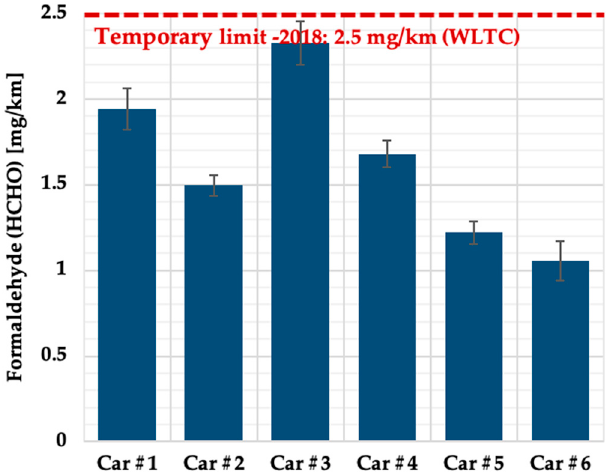
Figure 7. Formaldehyde emissions from the in-use methanol taxis.